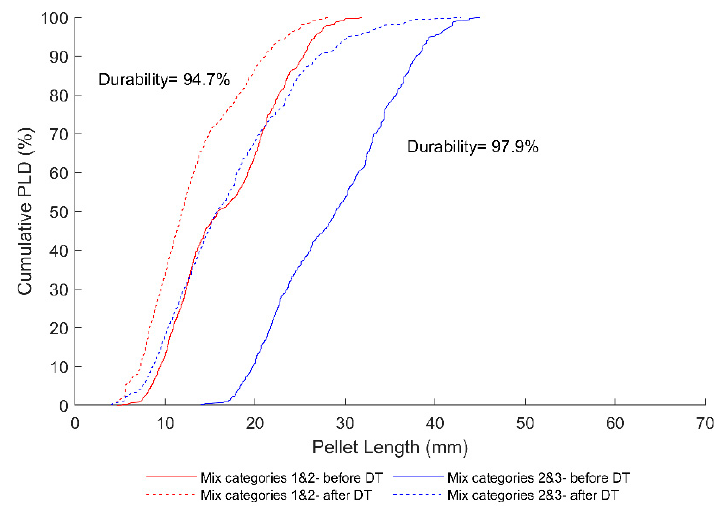
Figure 7. Pellet length distributions and mechanical durability values of torrefied mixed wood pellets: combination of categories.